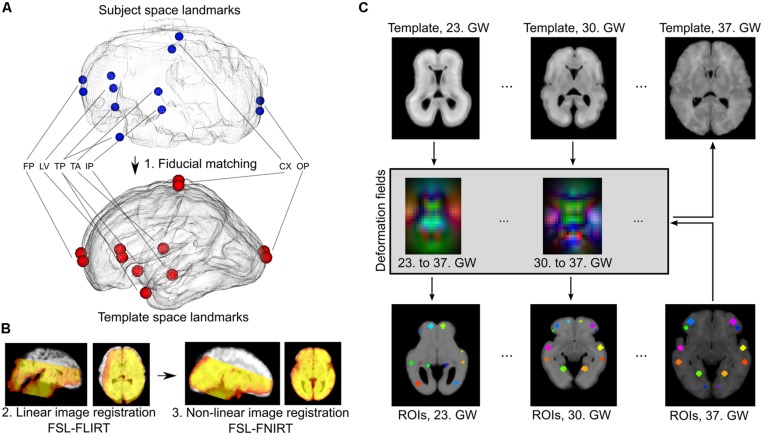
Registration of fetal fMRI data to anatomical standard images and ROI propagation across developmental phases. (A) Landmark-based initial registration was used to match the averaged BOLD fMRI images of fetuses and GW specific fetal template brains. FP, fontal pole; LV, lateral ventricles, frontal horn; TP, temporal pole; TA, thalamic adhesion (midline); IP, midline point of the interpeduncular cleft in the midbrain; CX, topmost point of the convexities; OP, occipital pole. (B) Second step of the fetal to standard image registration, carried out with intensity-based algorithms: linear (FLIRT) and non-linear (FNIRT) registrations in the FSL software. (C) Establishing GW-specific regions with a longitudinal label propagation approach. First row: for each GW from the 23rd to the 37th, a high-resolution anatomical template was used, between which pair-wise non-linear transformations were calculated (second row). These transformations were used to transform the ROI system into any GW (third and fourth rows).